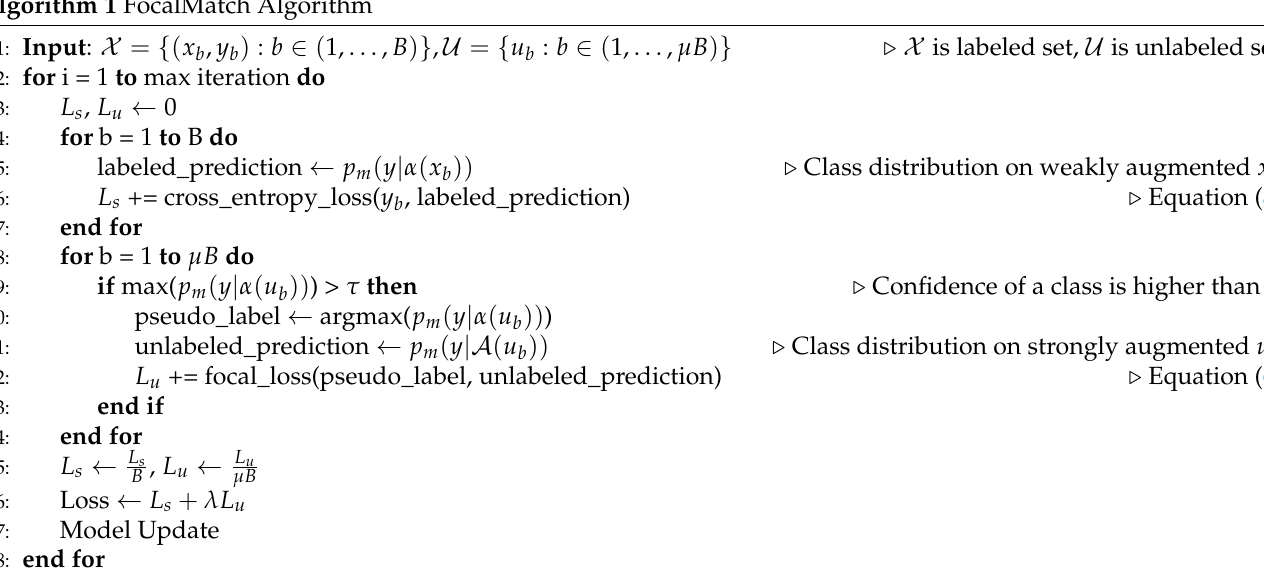
Algorithm 1 FocalMatch